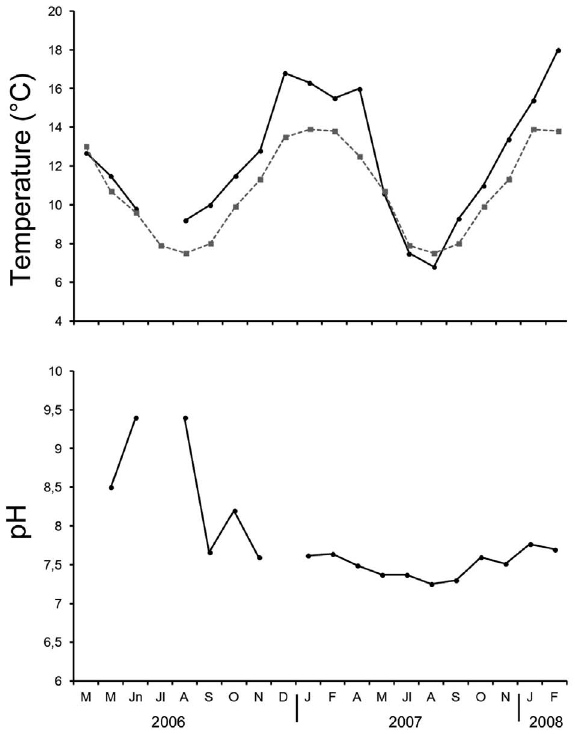
Fig. 4. – Monthly variation in sub-superficial temperature and pH of water in Bahía Bustamante (black line) between March 2006 and February 2008. Mean temperature of superficial water is indicated by a grey line (Servicio de Hidrografía Naval 2008).